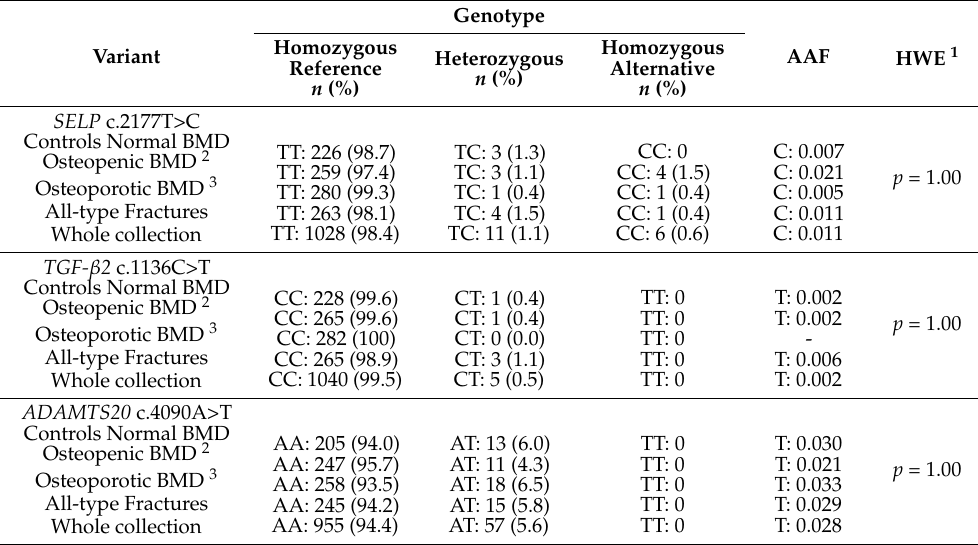
Table 4. Genotype and allele frequencies of the three shortlisted variants in the MOFS collection.